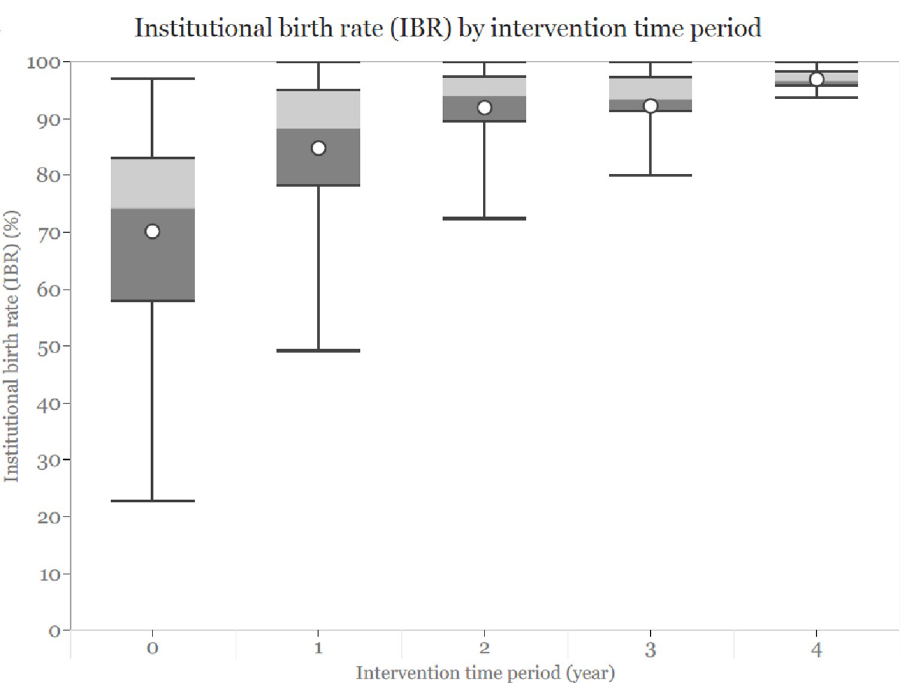
Fig 3. Unadjusted institutional birth rates by intervention time